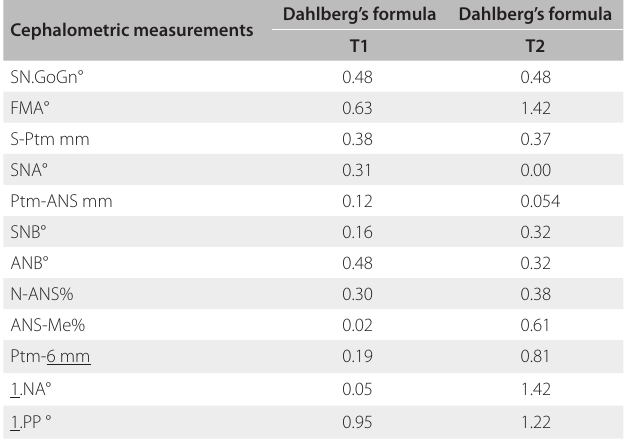
Table 2. Comparison of starting forms at T1. Cephalometric